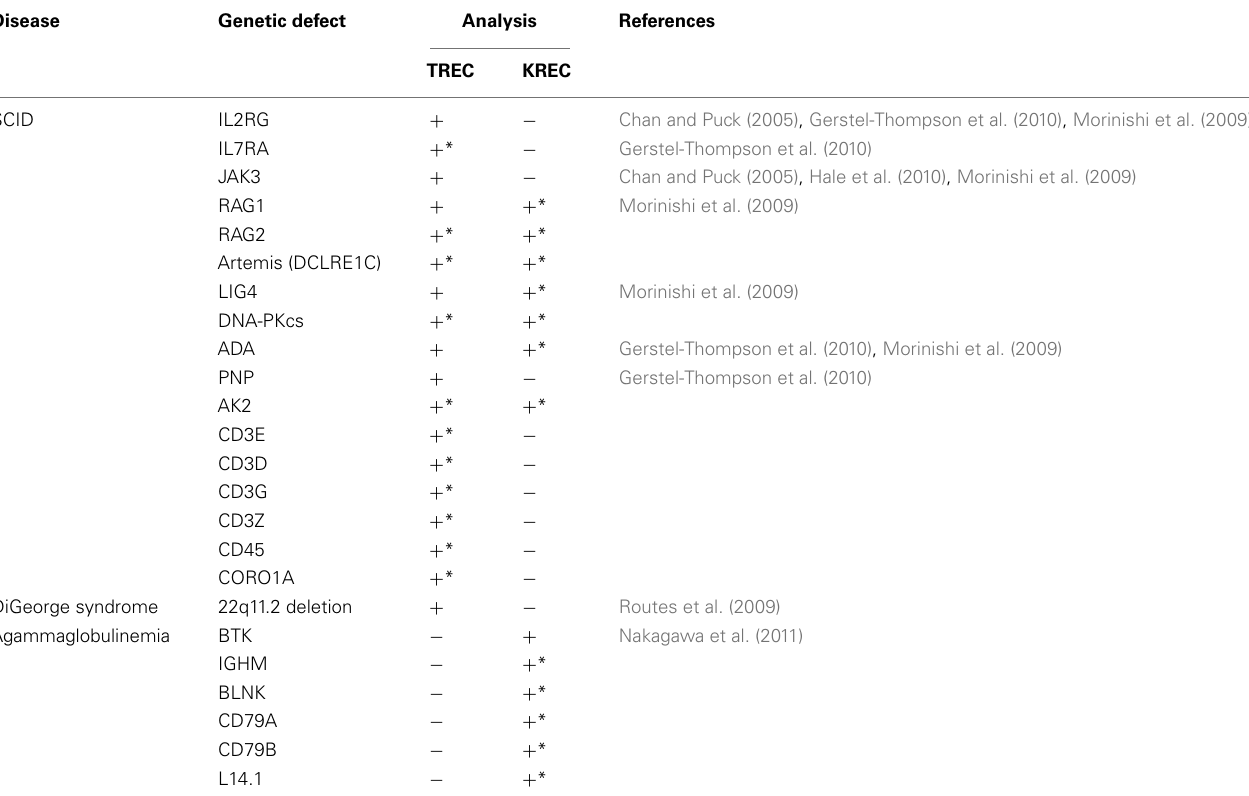
Table 1 | Application ofTREC and/or KREC analysis in newborn screening to identify immunodeficient patients with various types of genetic defects that result in extremely low totalT- and/or B-cell